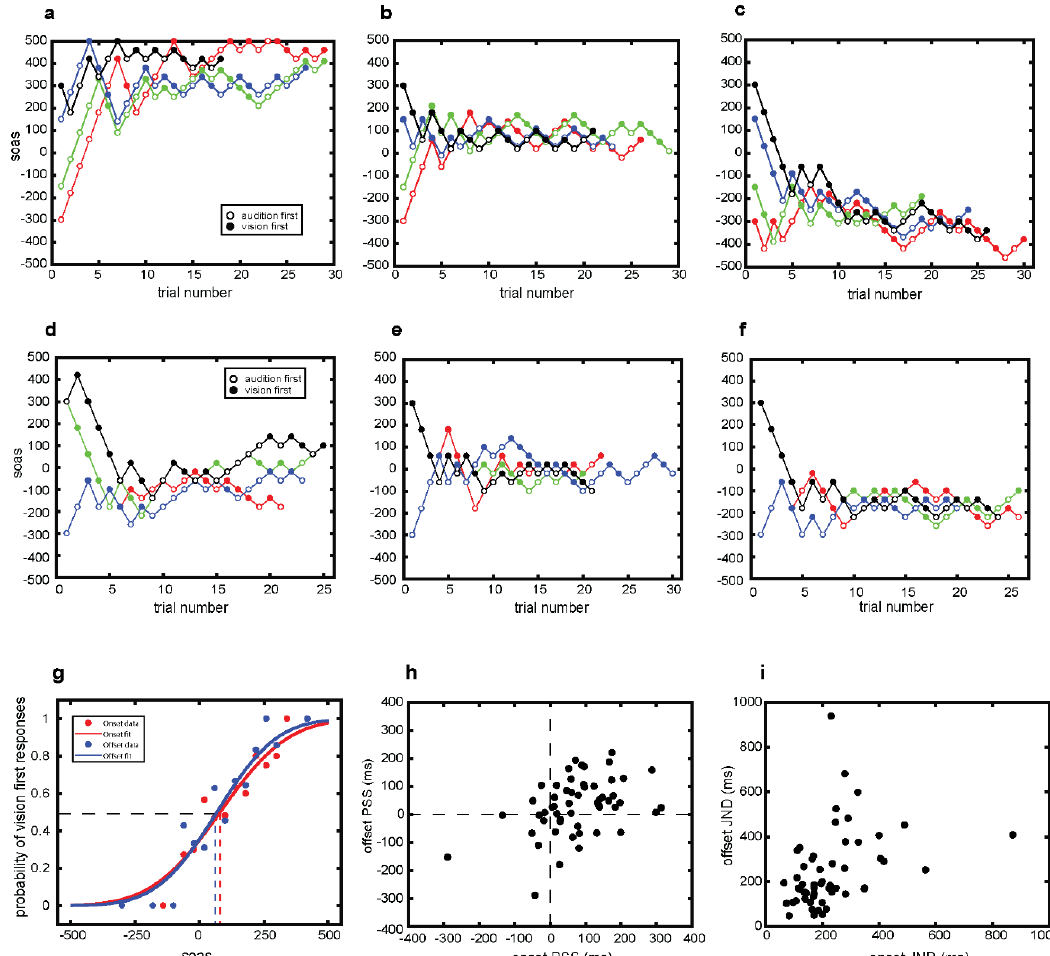
Figure 2. Estimates of PSS and JND derived from fitting psychometric functions to data collected using an adaptive staircase procedure. Panels ( a – f ) examples showing trial-to-trial variations in SOA, with each panel example being data from a given participant tested using four, randomly interleaved staircase sequences (sequences are plotted with different color symbols). Panels ( a – c ) were obtained in the onset condition and panels ( d – f ) come from the offset condition. Data in panels ( a ) and ( d ) are from one participant, ( b ) and ( e ) from another, and ( c ) and ( f ) from a third. Open and filled symbols designate the participant’s responses on each trial (solid = vision first and open = auditory first). The individual sequences for the onset conditions illustrate staircases with different starting points or SOAs (i.e., black 300 ms, blue 150 ms, green −150 ms, and red −300 ms). For the offset condition, each staircase is defined by its starting point and the modality used as the standard, hence, black 300 ms and visual standard, green 300 ms and auditory standard, blue −300 ms and visual standard, red −300 ms and auditory standard. Details of the staircase procedure and derivation of PSS and JND are described in the text. ( g ) Psychometric functions fitted to the onset (red) and offset (blue) data of one participant. Red and blue dashed lines represent the onset and offset PSS, respectively, estimated as the SOA corresponding to 50% probability of making vision first responses. ( h ) Scatterplot showing for each participant, the PSS value associated with that person’s onset and offset data. Across the 54 participants, the correlation between PSS onset and PSS offset was significantly different from zero ( r = 0.41, n = 54, and p = 0.002). Averaged over all participants, onset PSS values (x ̅ = 77.3 and SE =14.4) were larger than offset PSS values (x ̅ = 30.2 and SE = 13.6). ( i ) Scatterplot showing each participants JND for the onset and offset conditions. There was no difference between the average onset JND (x ̅ = 230 and SE = 18.7) and for offset (x ̅ = 247.6 and SE = 23.4) condition. However, the correlation between those onsets and offset values was significant ( r = 0.38 and p = 0.005).